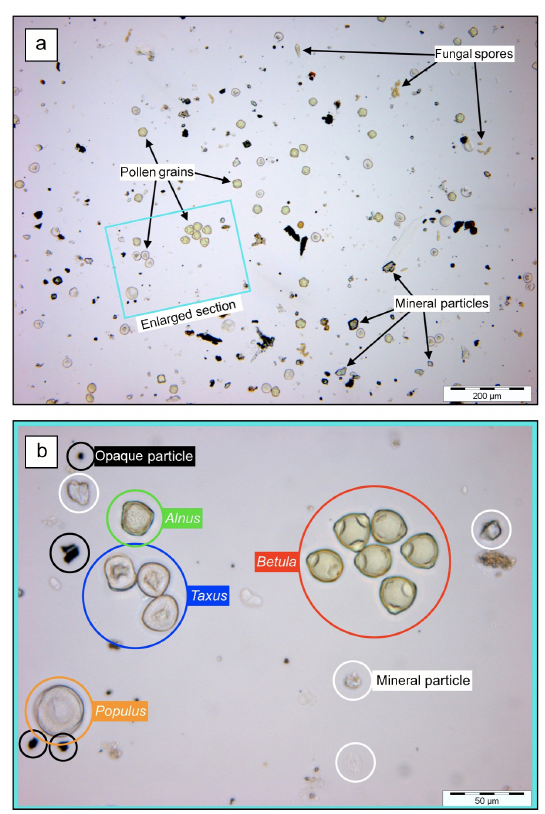
Figure 9. (a) Microscope photograph of a sample carrier loaded with various aerosol particles deposited during a multicopter UAV collection flight at an altitude of 300ma.g.l. The section bounded by the cyan rectangle is shown enlarged in (b) . (b) Enlargement shows clusters of Corylus and Taxus pollen grains as well as transparent mineral and opaque particles in various sizes.